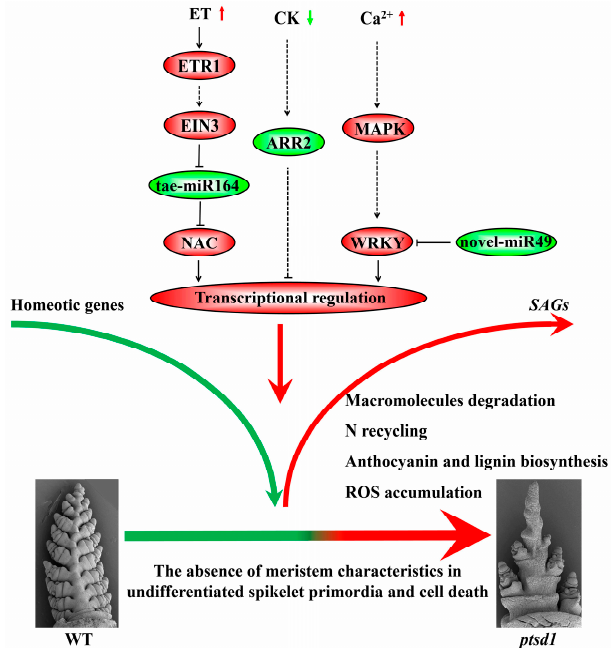
Figure 10. A hypothesis of molecular regulatory network in ptsd1 . The modules coloured in red are highly expressed in ptsd1 -YS and modules coloured in green are lowly expressed in ptsd1 -YS. The real lines indicate the direct interaction, the dotted lines indicate the indirect interaction.